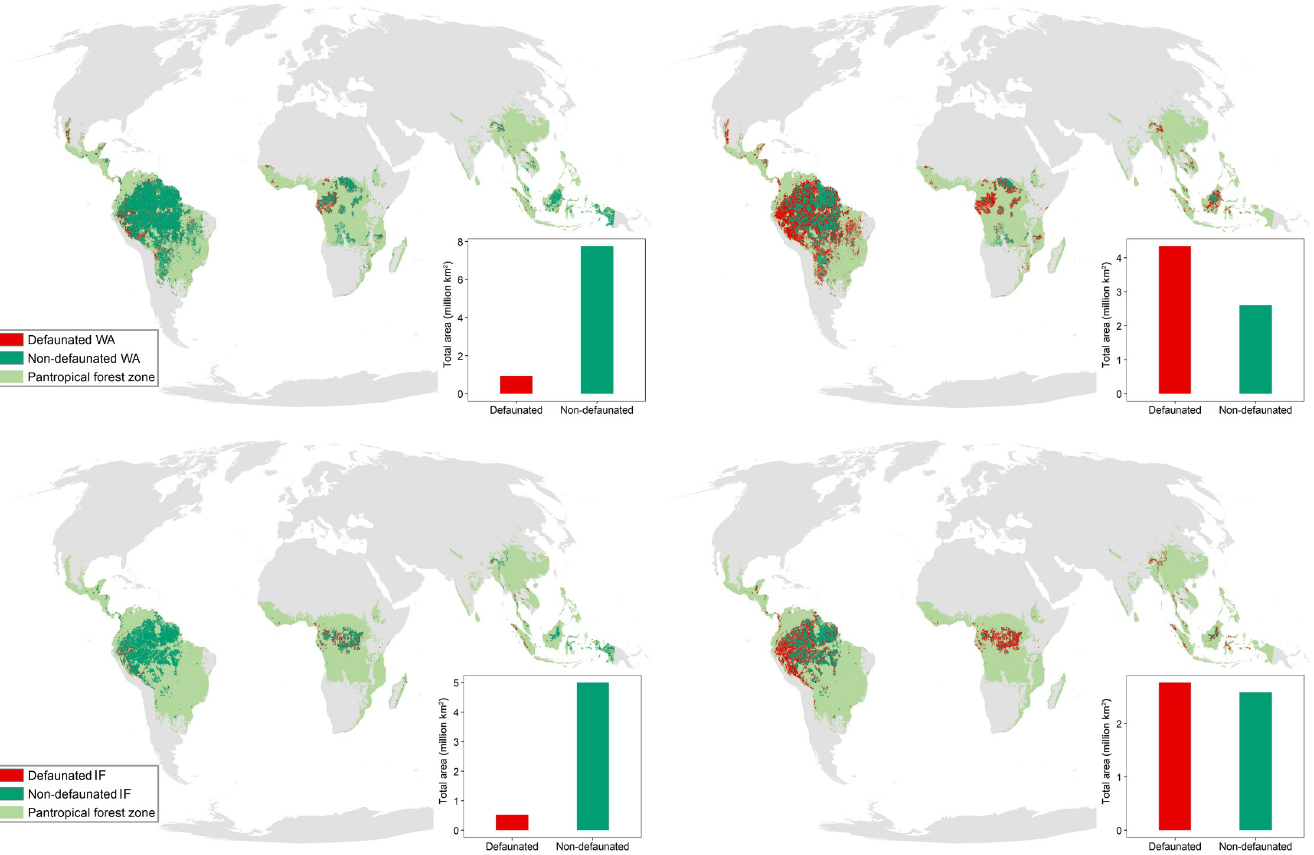
Fig 4. Geographic variation and spatial extent of hunting-induced defaunation for all species (left-hand side; A,C), and for large-bodied species (right-hand side; B,D) in WAs (A,B) and IFs (C,D). The insets represent the total area of forest (y-axis) predicted to be defaunated (DI > 0.1, red) and intact (DI � 0.1, green) in the respective graphs. Available at https://figshare.com/projects/Intact_but_emtpy_forests_Patterns_of_hunting-induced_mammal_defaunation_in_the_tropics/ 31118. DI, defaunation index; IF, intact forest; WA, wilderness area.